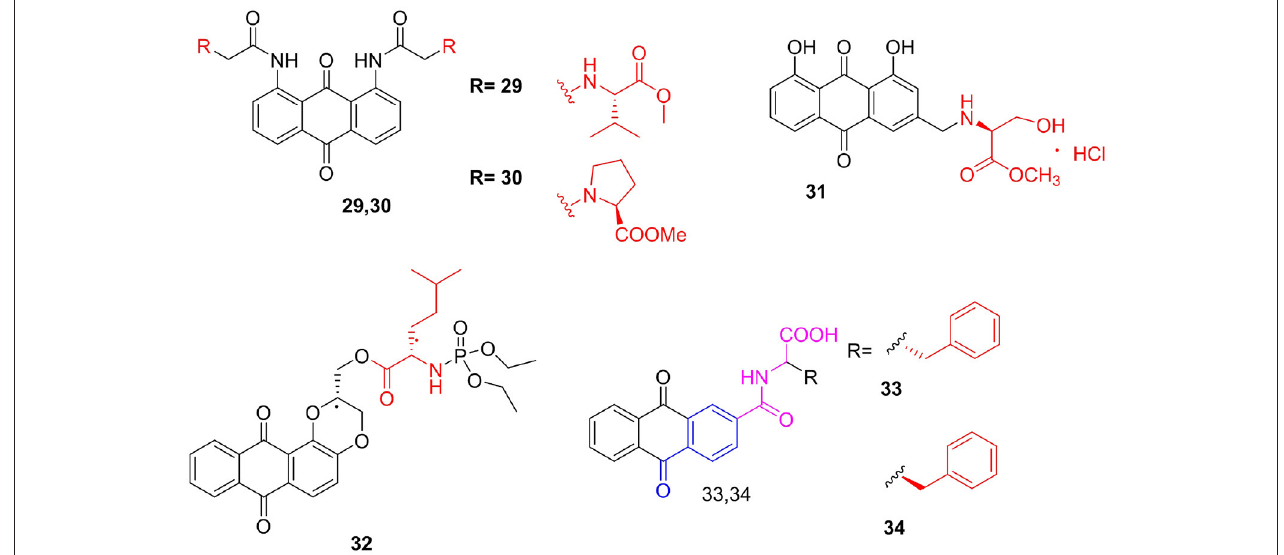
FIGURE 4 | Anthraquinones amino acid